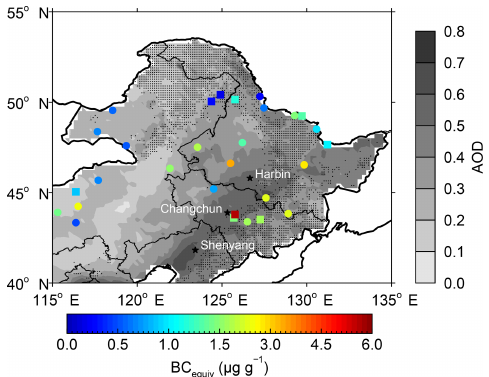
Figure 10. Spatial distribution of the measured BC equiv concentra- tion in surface snow in NEC. Circles and squares represent the snow samples collected in 2010 (Wang et al., 2013) and 2014 (Wang et al., 2017), respectively.